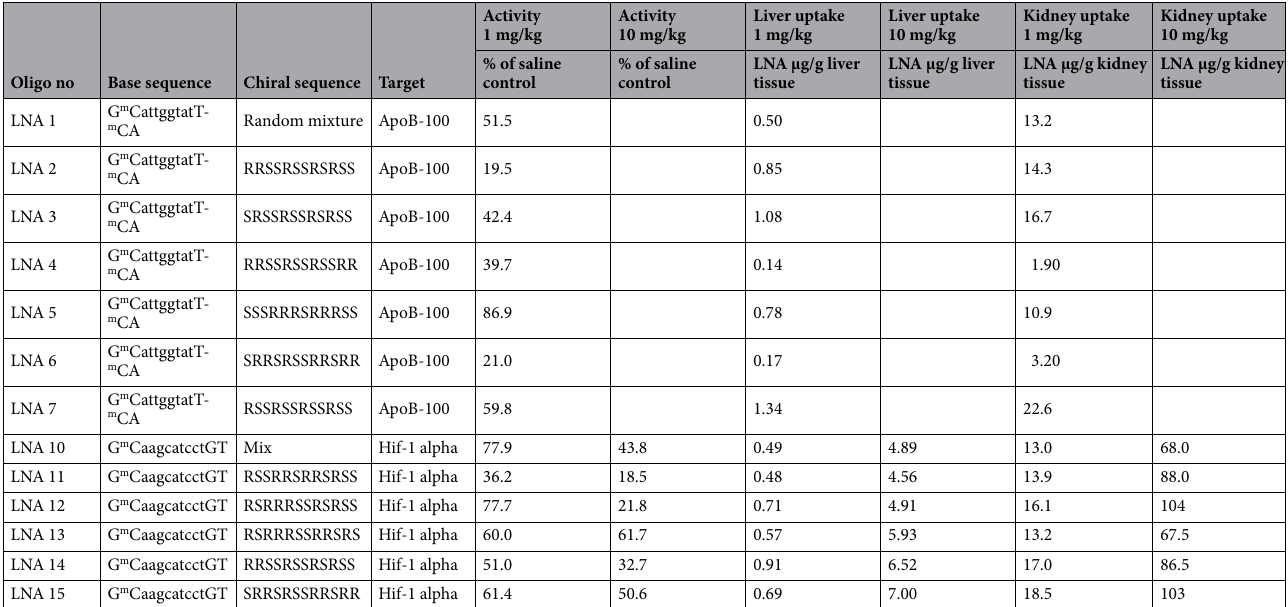
Table 1. Design, nucleobase sequence, PS chirality and in vivo data for 11 LNAs. LNA and DNA nucleotides are respectively denoted by upper and lower case letters. For LNA nucleotides all cytosine nucleobases are replaced by 5-methyl-cytosine ( m C). LNA nucleobase/PS chiral sequence and target information is shown in the columns to the left; antisense activity is shown at 1 and 10 mg/kg in the middle of the table; LNA uptake in liver and kidney at 1 and 10 mg/kg is shown in the 4 columns to the right.